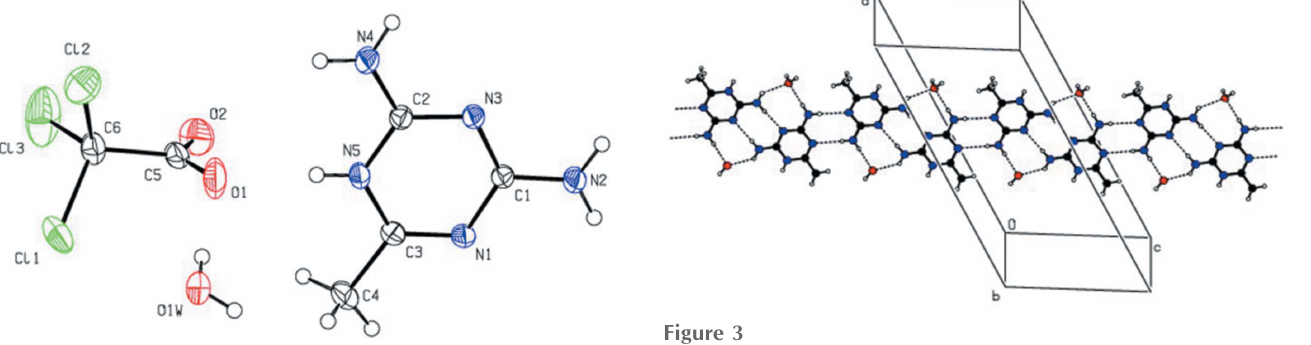
Figure 1 The molecular structure and atom-numbering scheme for the title salt, with displacement ellipsoids drawn at the 40% probability level.